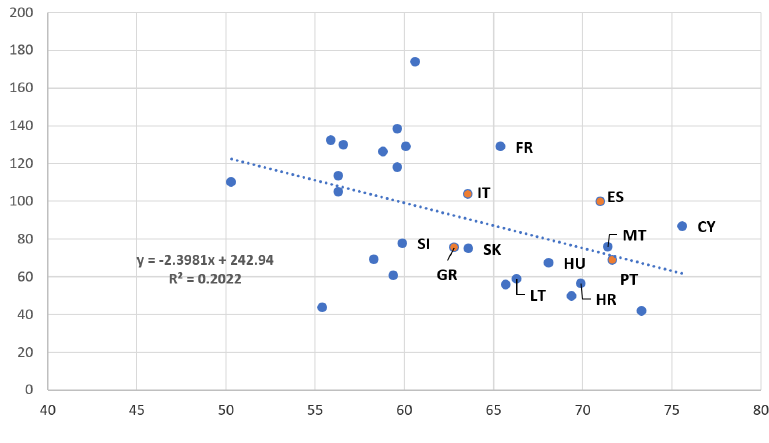
Figure 7: Relation between productivity ( y -axis) and rigid entry/exit schedule ( x -axis), 2010